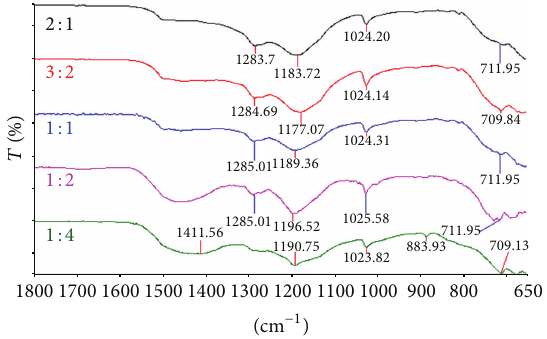
O contents of the synthesized dehydrated 2 3